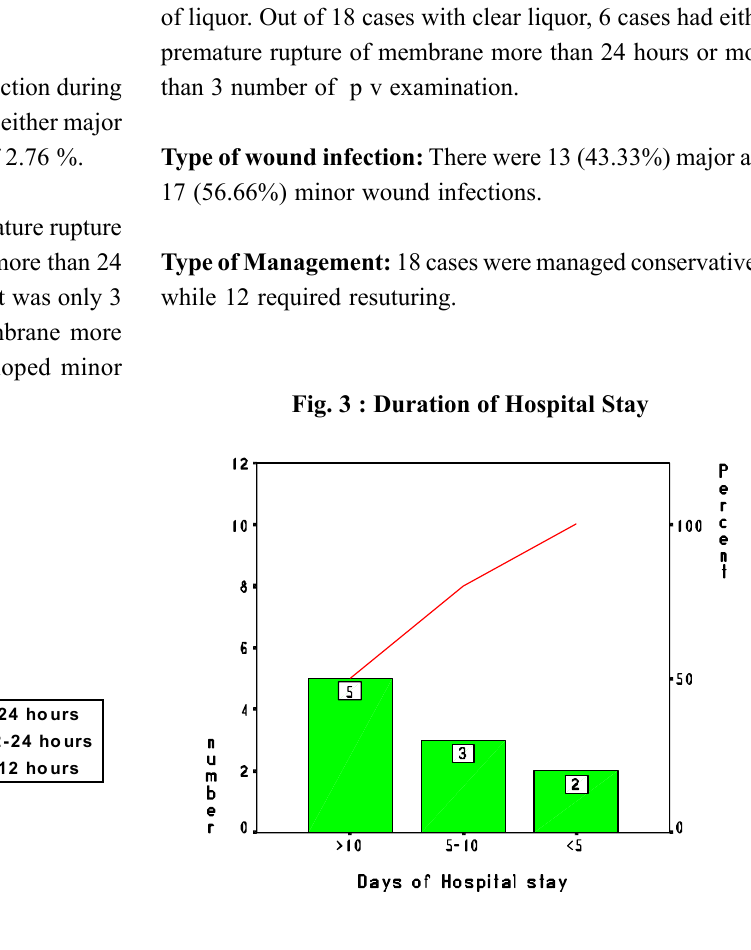
Fig. 1 : Premature rupture of membrane